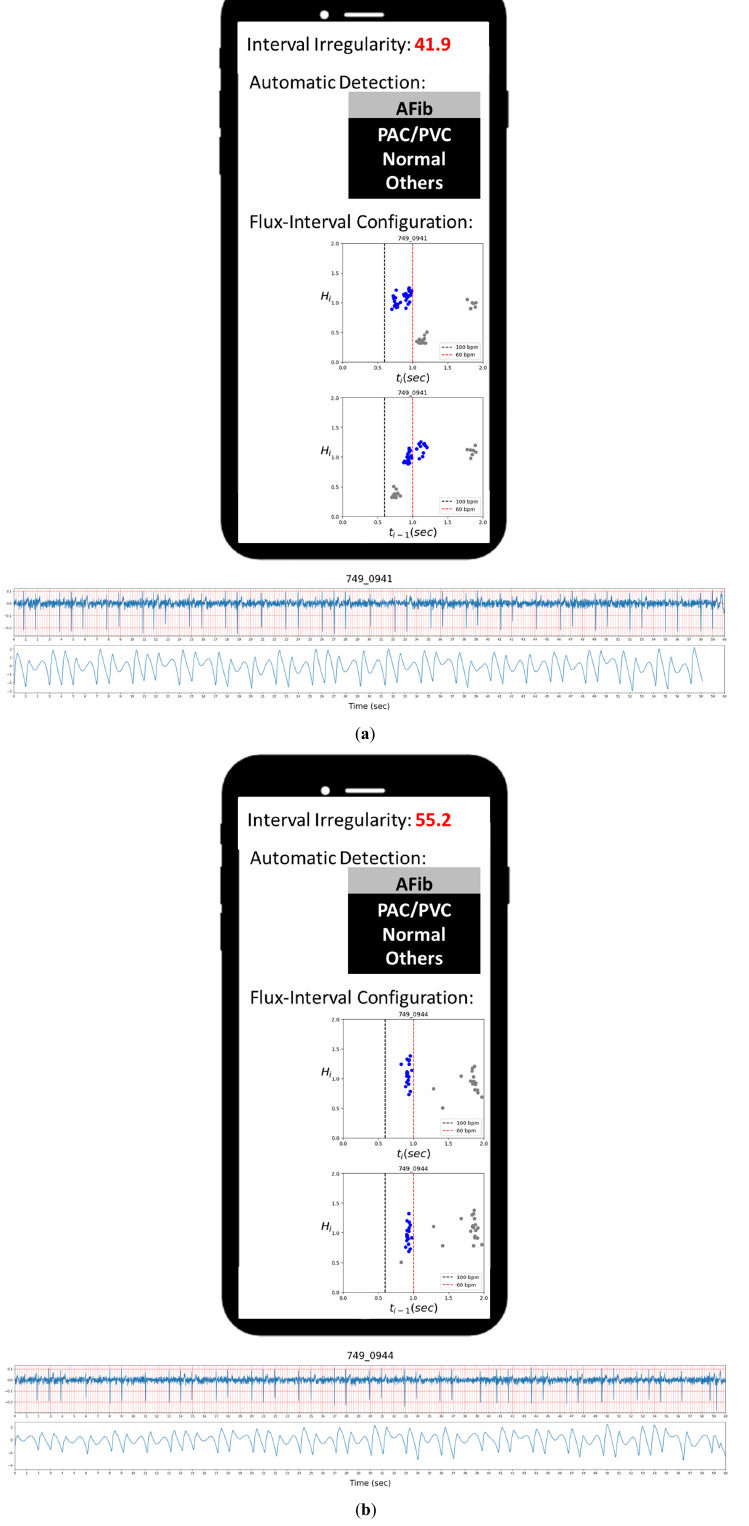
Figure 8. ( a , b ) Two cases of non-AFib (ECG labeled as others, atrioventricular block) correctly detected. In both cases, their irregularity indexes are very high, but their regression RMSE on the main cluster is less than the threshold of 0.06. Thus, they are automatically detected as non-AFib. Their flux interval configurations are similar to PAC/PVC but far from AFib.